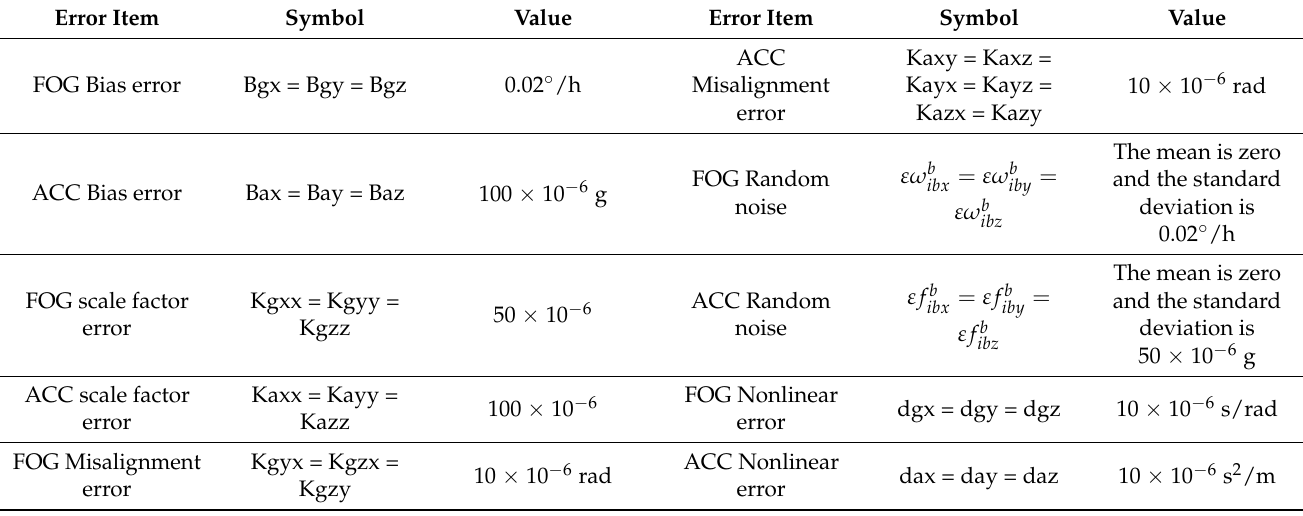
Figure 5. The sensor measurements generated according to the 24-position calibration. Table 2. The values of each error